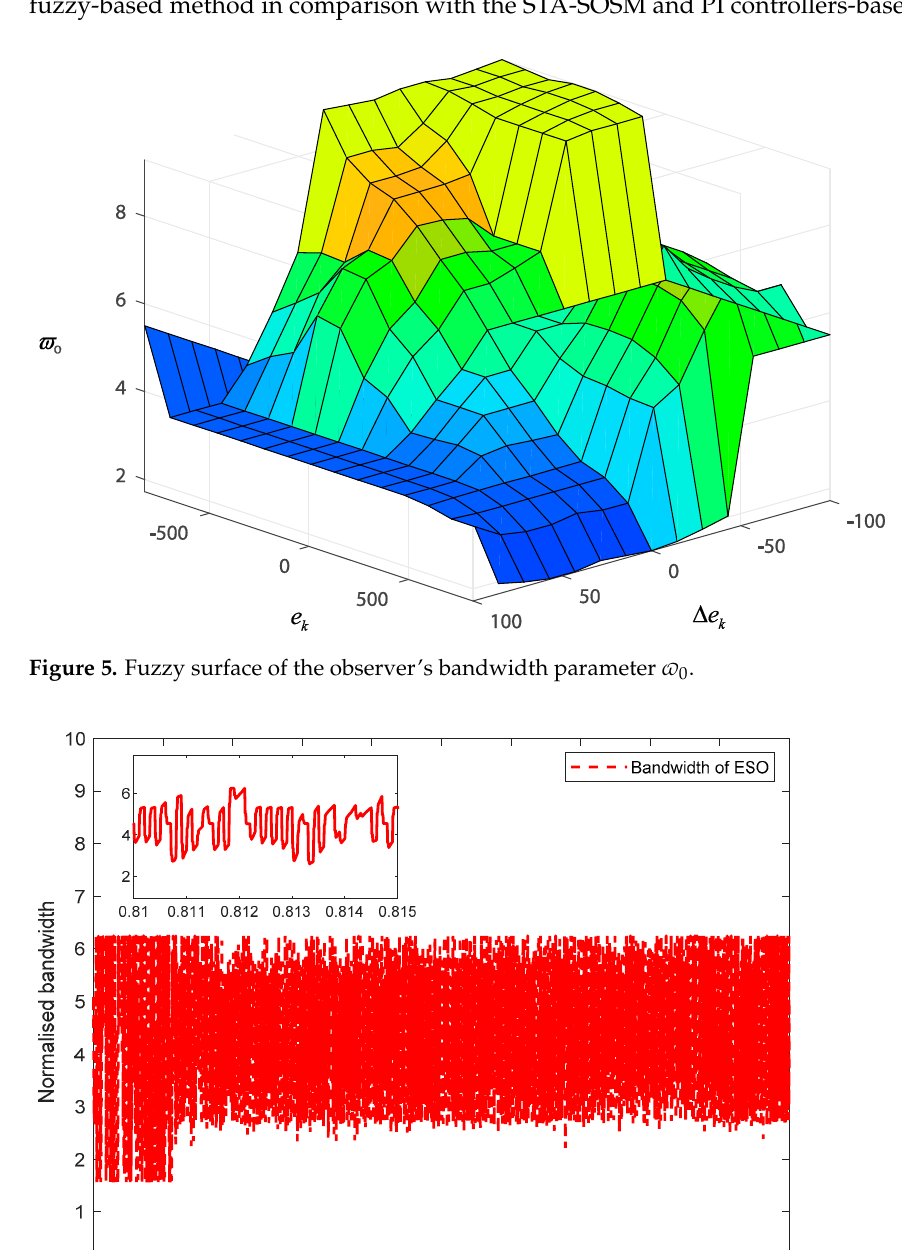
Figure 6. Time histories of the observer’s bandwidth control